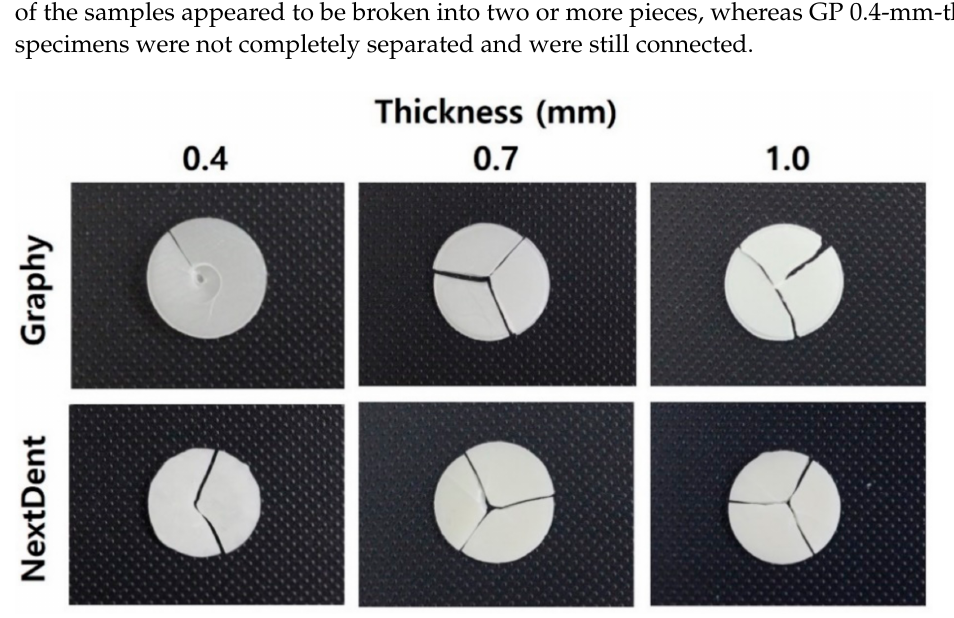
Figure 7. Representative fractured patterns of the various experimental